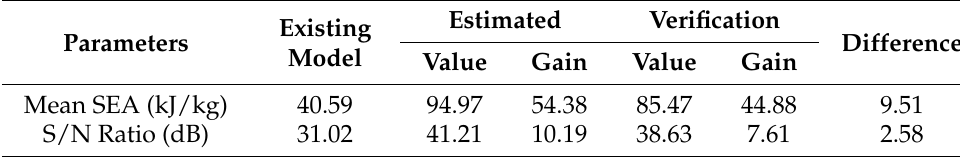
Table 10. Verification of The Optimized Model Summary.